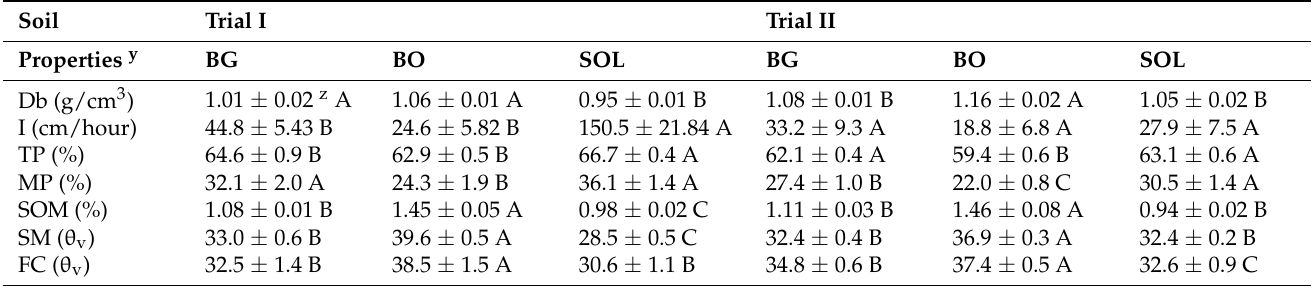
Table 1. Effects of tillage practices on soil physical properties in a corn agroecosystem from field plots managed in no-till black oat (BO), bare ground (BG), and solarization (SOL) plots. Trial II